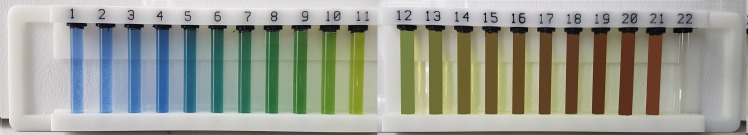
The classic Forel-Ule scale: 21 coloured liquids in vials.